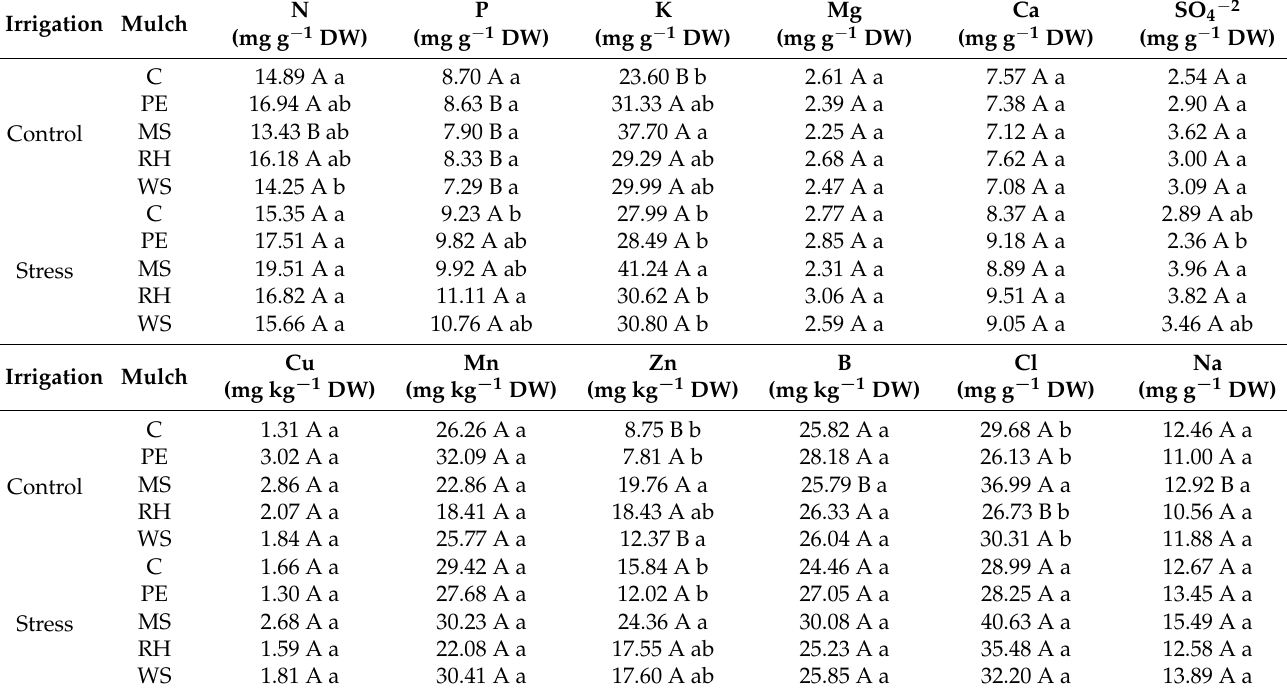
Table 2. Macronutrient and micronutrient concentrations in leaves of escarole plants of the commer- cial variety “Brillantes” non-mulched or subjected to different mulching treatments and cultivated under control (well-watered) and water stress (70% ETc)